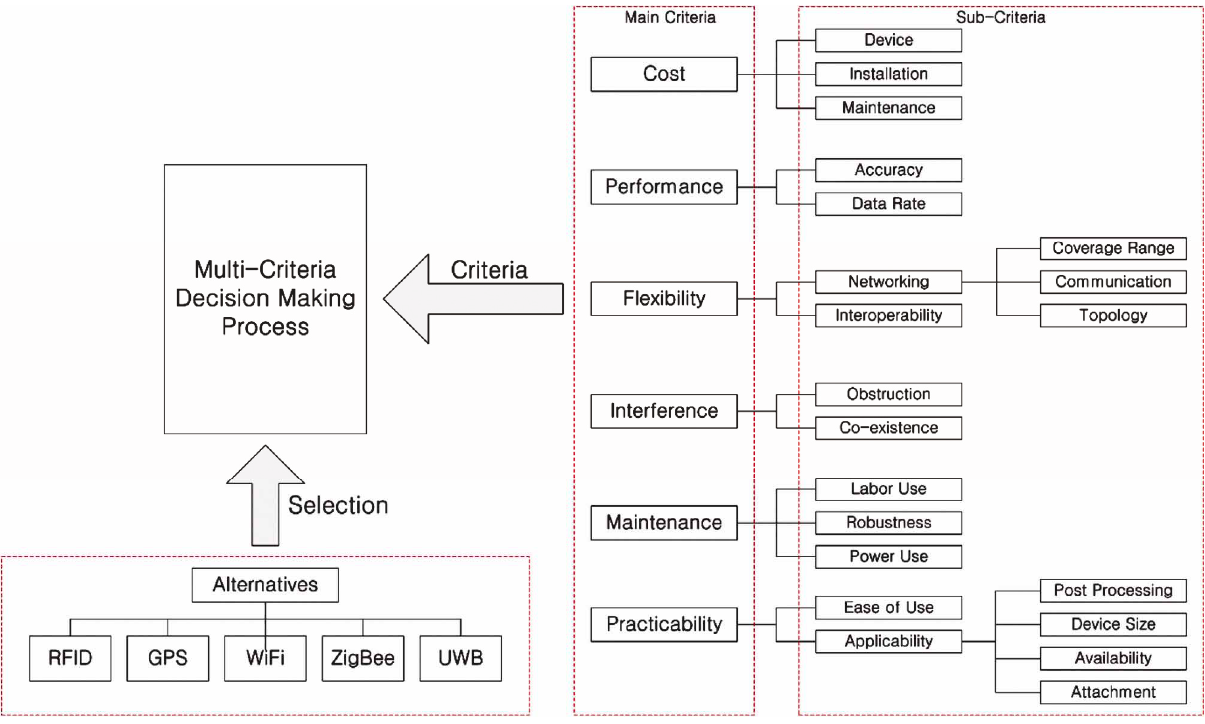
Fig. 3. Proposed decision-making model for selecting wireless technology for a construction assets tracking